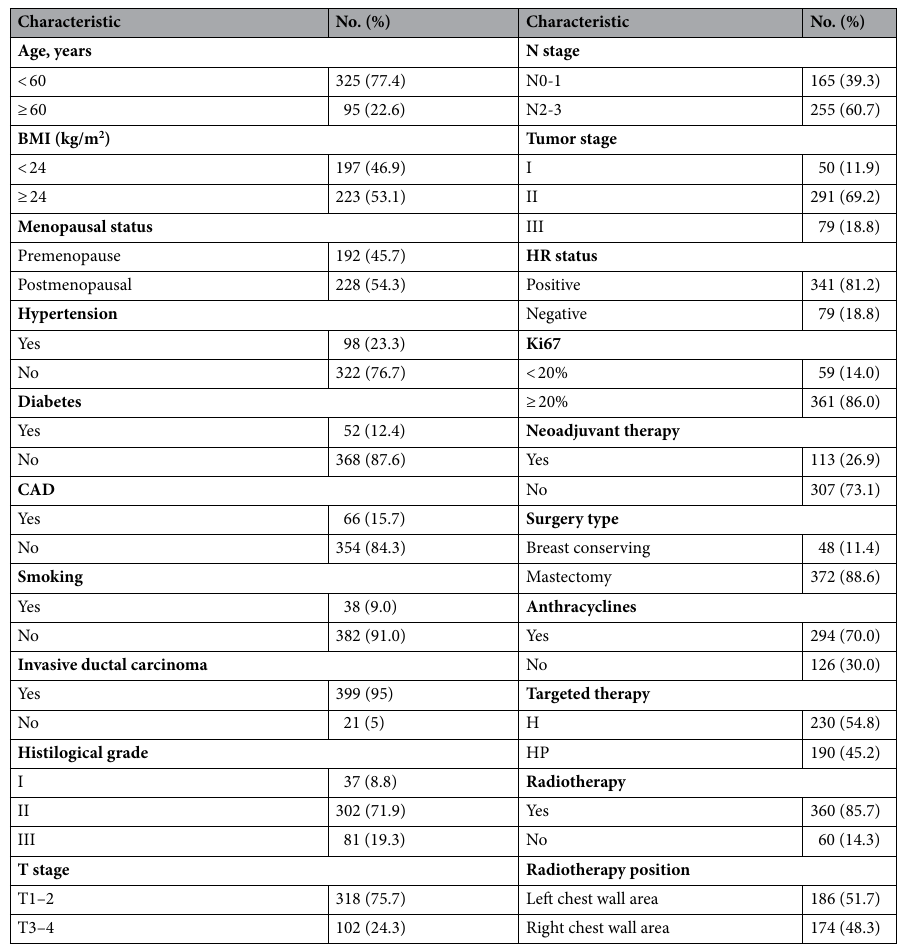
Table 1. Clinicopathological characteristics of 420 patients with early-stage breast cancer treated with anti- HER2-targeted therapy. CAD coronary artery disease, H trastuzumab, HP trastuzumab and